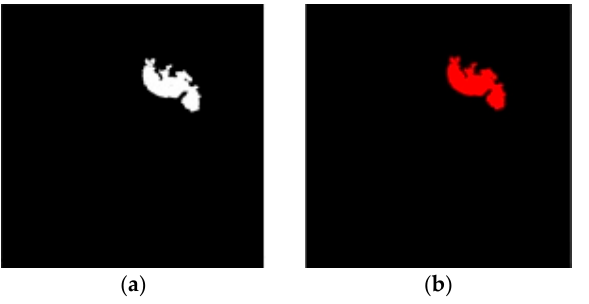
Figure 8. Ganglion cyst extraction with labelling. ( a ) Candidate cyst, ( b ) cyst after labelling.